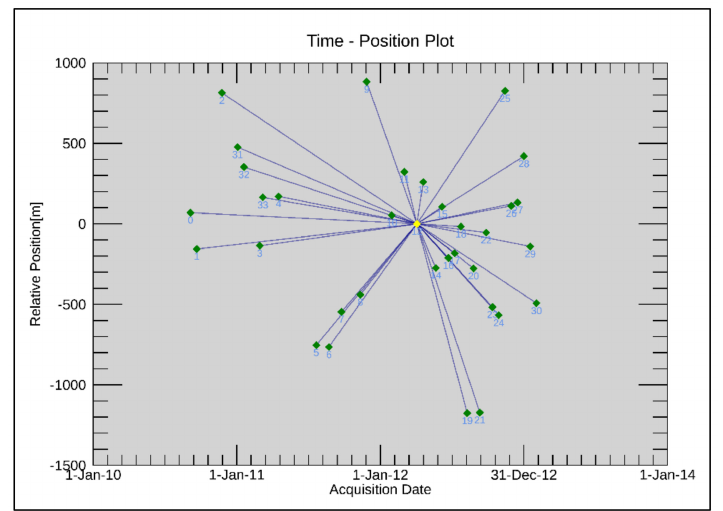
Figure 5. Connection graph of the descending orbit. The yellow dot identifies the master image, the green dots represent the slave